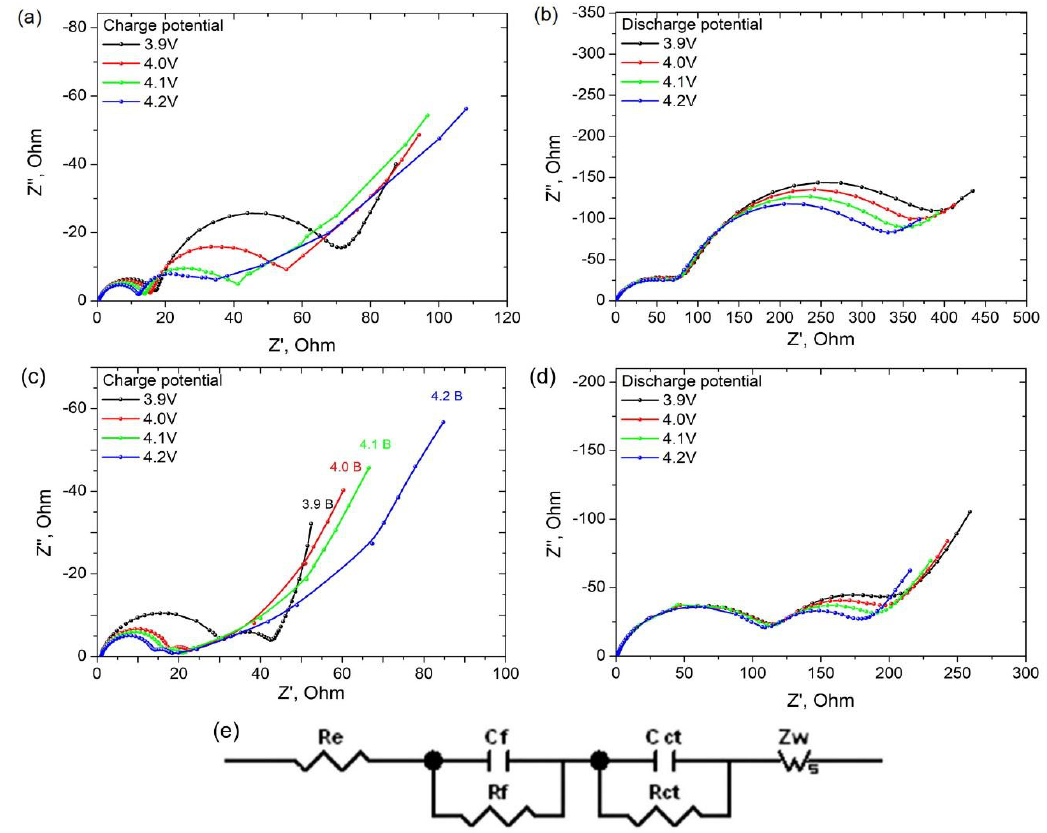
Figure 6. Nyquist plots for LiMn 1.95 Co 0.025 Ni 0.025 O 4 at charge ( a ) and discharge ( b ) potentials 3.9; 4.0; 4.1 and 4.2 V and plots for Li 1.1 Mn 1.95 Co 0.025 Ni 0.025 O 4 at the same charge ( c ) and discharge ( d ) potentials. The equivalent circuit used for the EI spectra fitting ( e ).